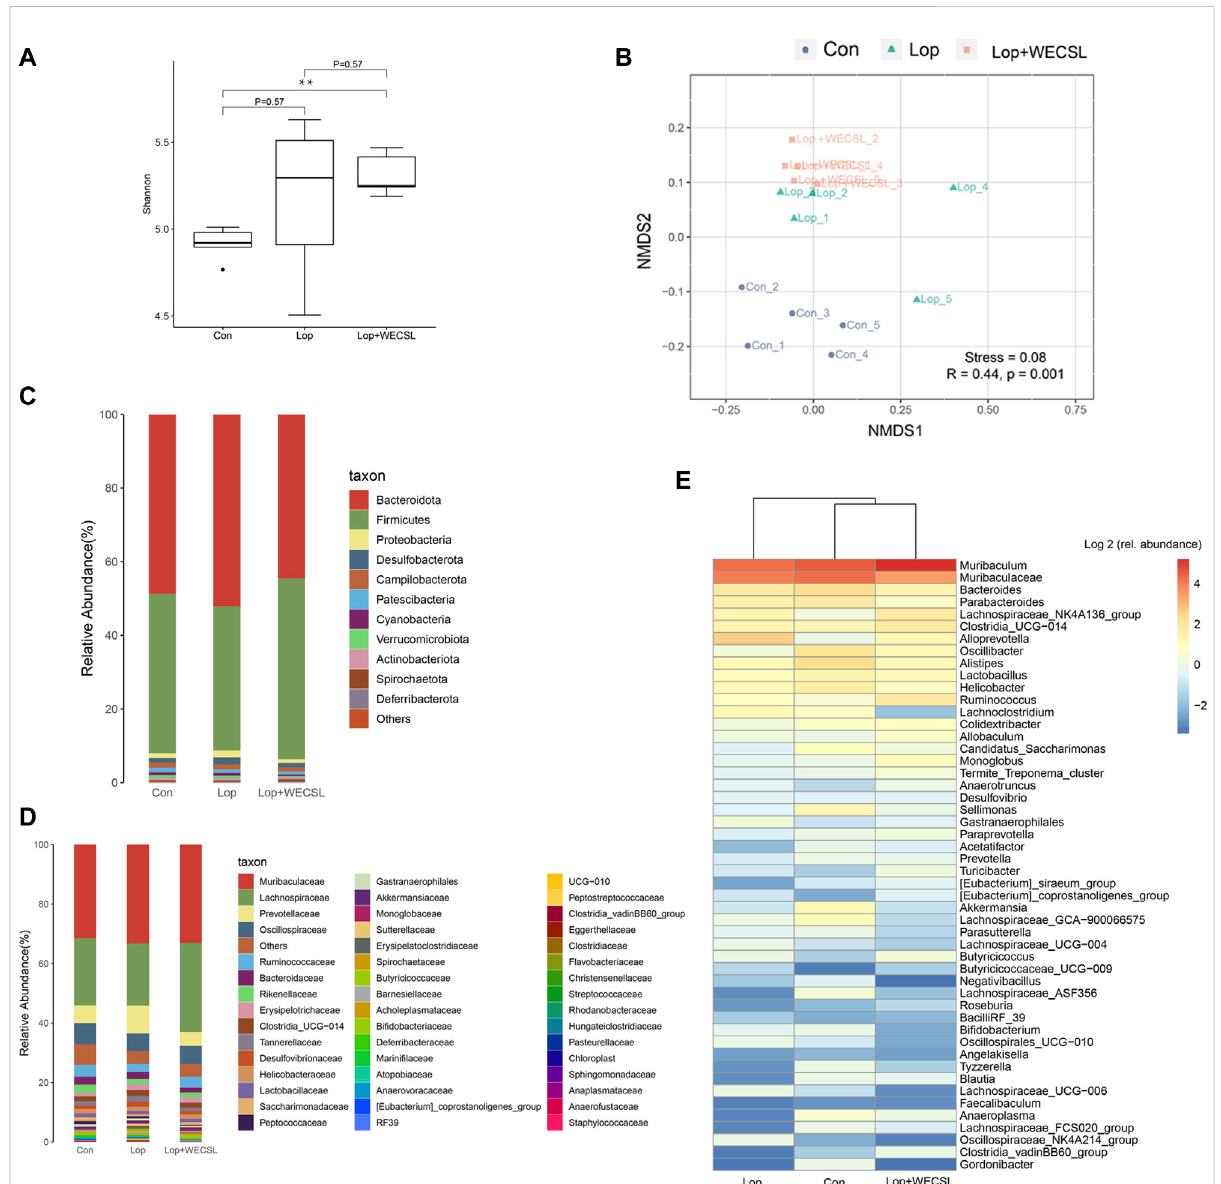
FIGURE 5 WECSL modulated gut microbiota structure in constipated mice (A) Alpha diversity determined using the Shannon index. (B) Beta diversity determined using the NMDS plot. (C,D) Changes in intestinal microbiota at the phylum level (C) and family level (D) . (E) Heap map showing the top 50 microbial